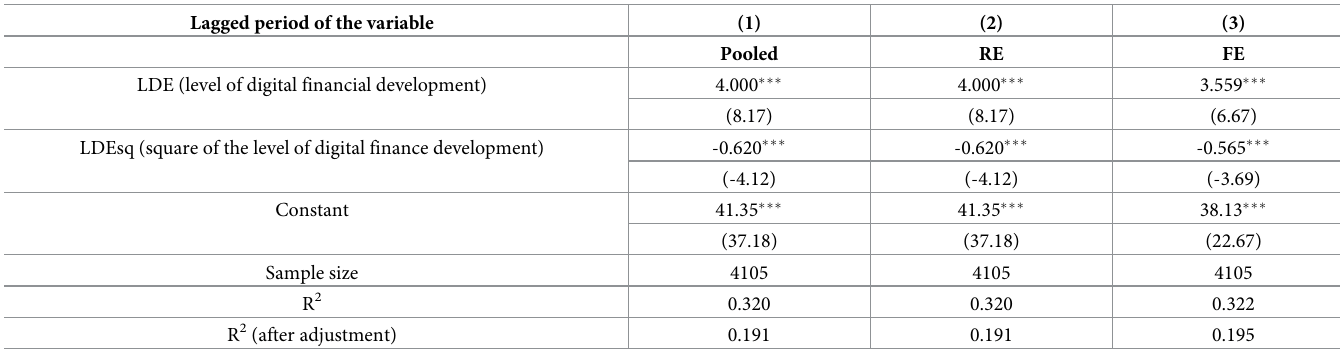
Table 4. Robustness test